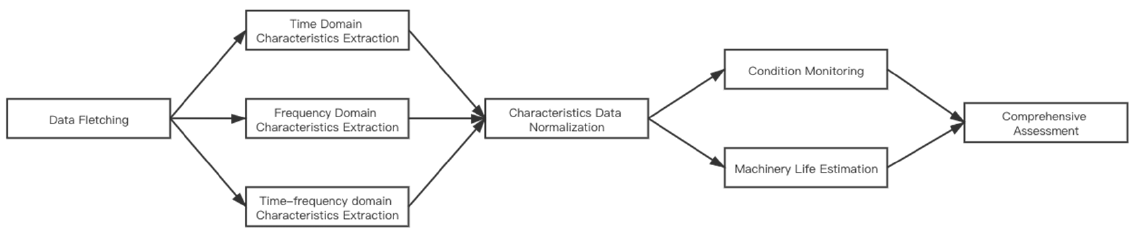
Figure 1. IRMS Edge–Cloud Architecture.